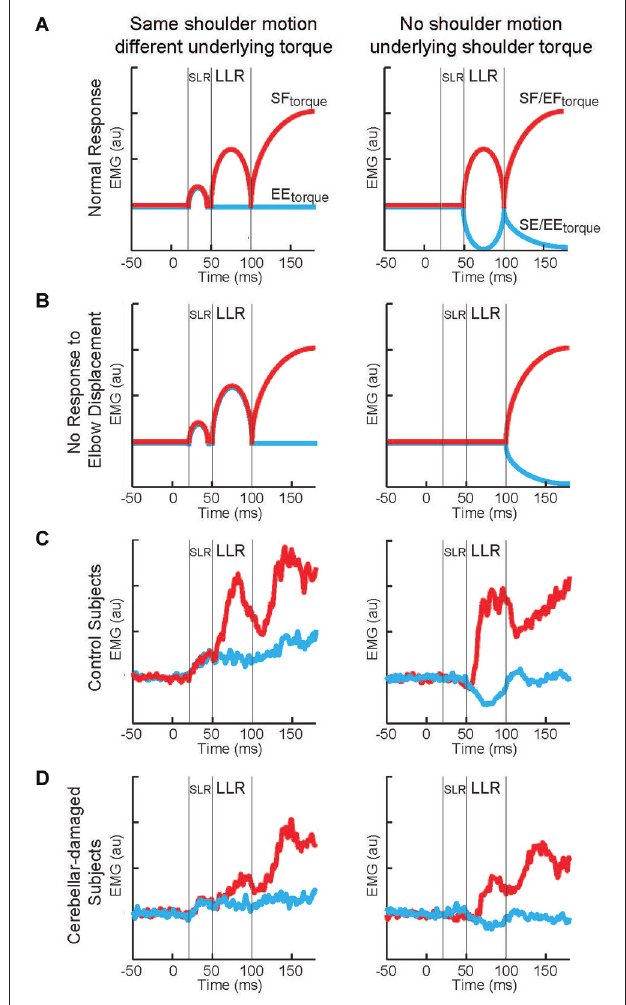
FIGURE 9 | Long-latency reflexes during cerebellar damage. (A) Cartoon of evoked activity from the shoulder extensor by healthy subjects. Panels on the left indicate responses to shoulder displacement caused by a shoulder flexor torque (red) and an elbow extensor torque (blue). Panels on the right indicate responses to elbow displacement caused by a shoulder + elbow flexor torque (red) and an shoulder + elbow extensor torque (blue). (B) Cartoon of predicted shoulder muscle activity if cerebellar damage eliminates the ability to integrate multi-joint muscle. (C) Group average of shoulder extensor muscle activity by a group of healthy subject. (D) Group average of shoulder muscle activity by a group of subjects suffering cerebellar damage. Figure modified with permission from Kurtzer et al.